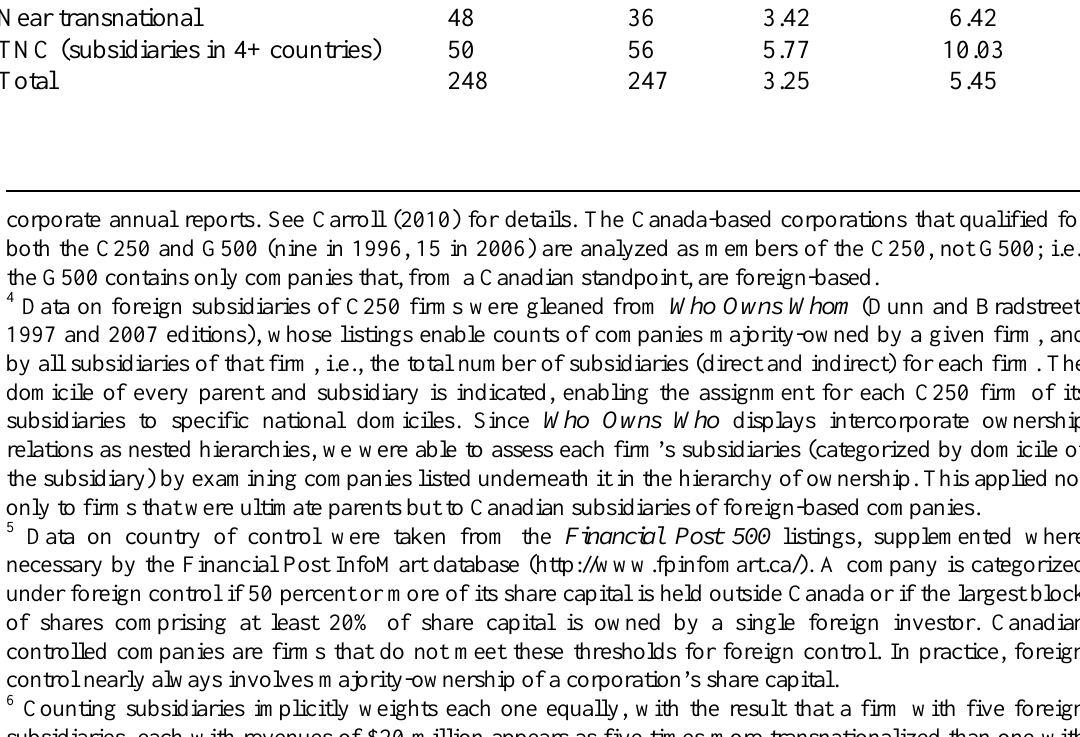
Table 2. Transnationality of C250 Corporations Transnationality N of firms Mean revenue ($Bill Can)